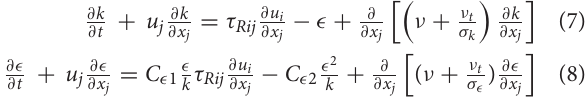
TABLE 2 | Comparison between experimental and CFD-predicted pressure drops. Test no.